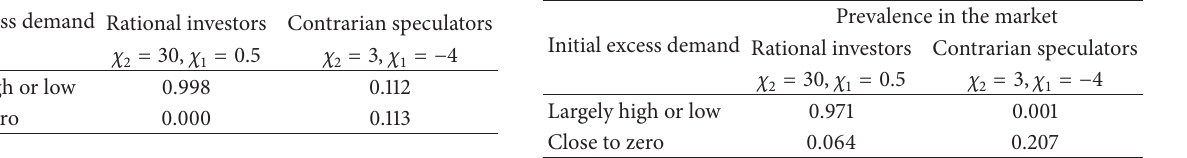
Table 4: Correlation between the returns of high- and low- risk assets resulting from the simulation of the model (ex-post